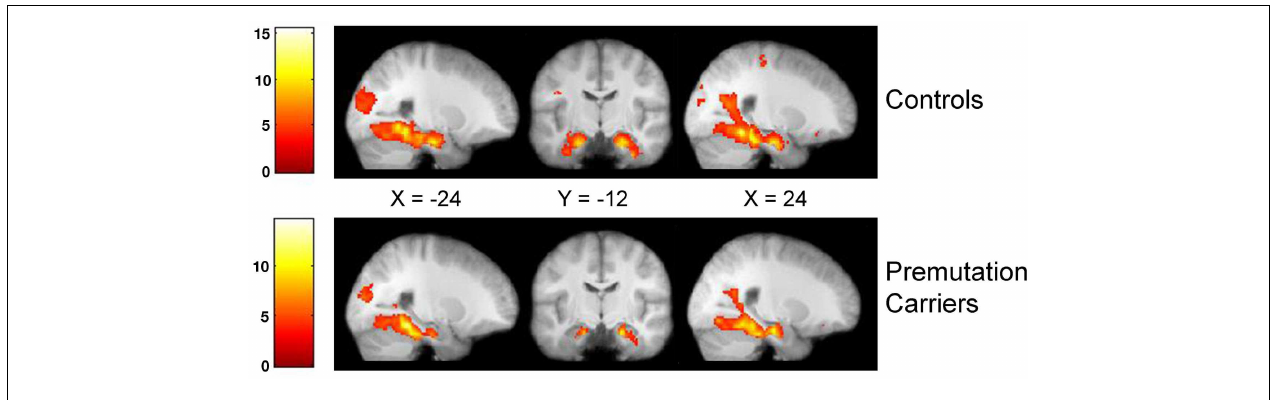
FDR correction. Both groups significantly activated the bilateral hippocampus during this task. Bars at left represent degree of activation using the t